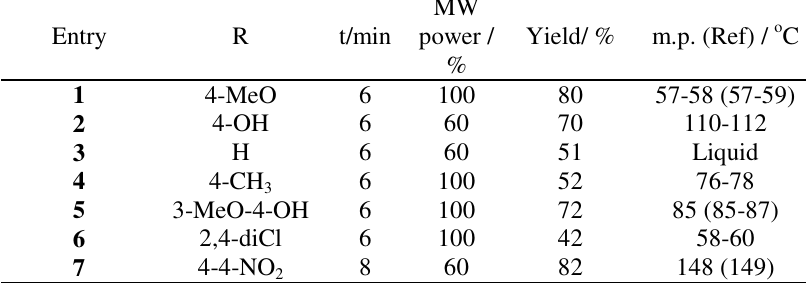
Table 2 . One-Pot Synthesis of Nitriles Catalyzed by KF / Al 2 O 3